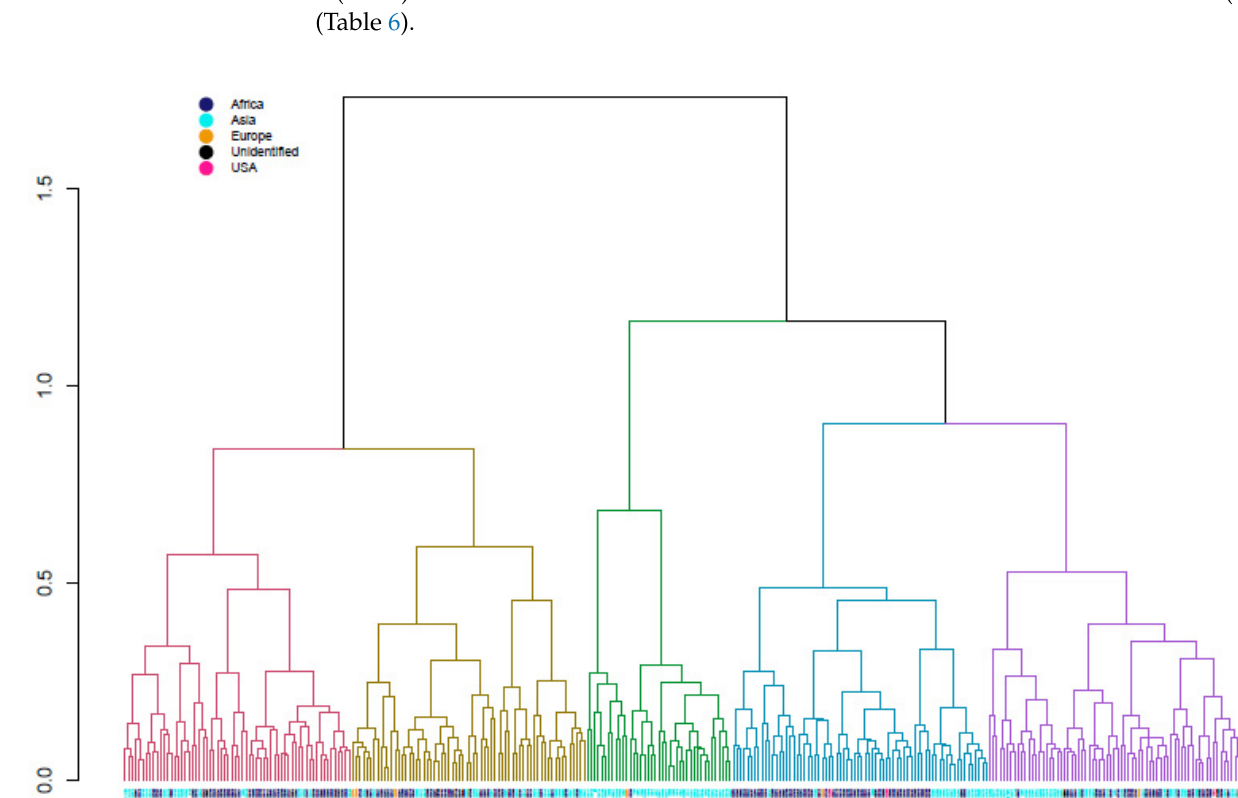
Figure 2. Dendrogram showing the clustering of 314 finger millet accessions based on forage quality and agronomic traits. Coloured branches indicate clusters 1 to 5 (from left to right). Table 5. Mean comparison among five clusters for agronomic and forage quality traits in 314 finger millet accessions. Cluster 1 (64) Trait #